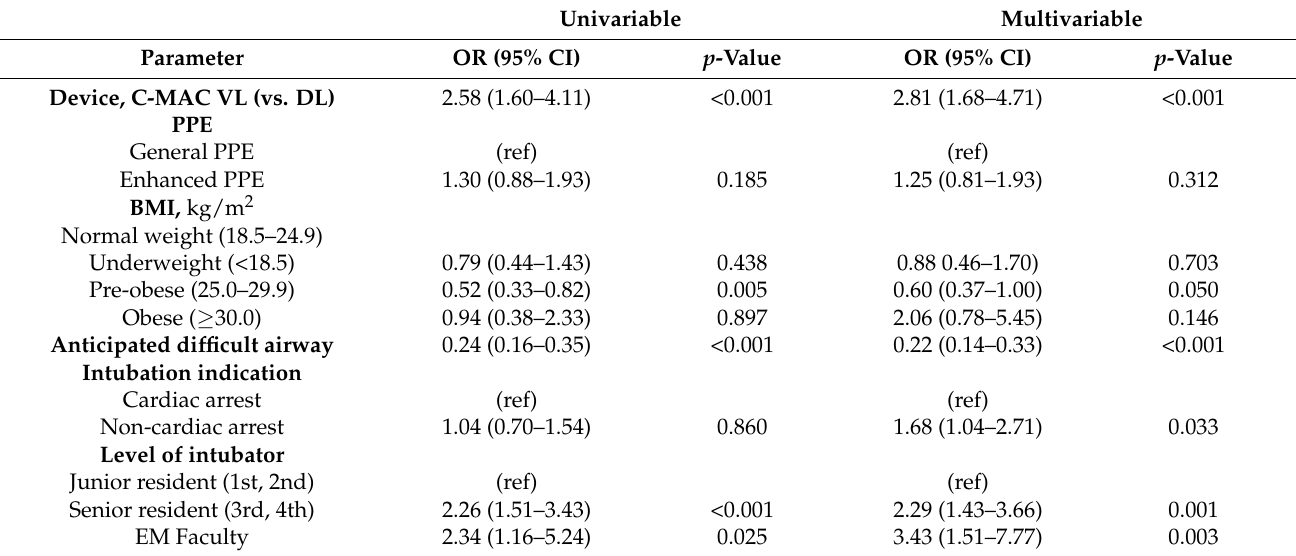
Table 3. Univariable and multivariable analyses to identify the factors associated with FPS. Univariable